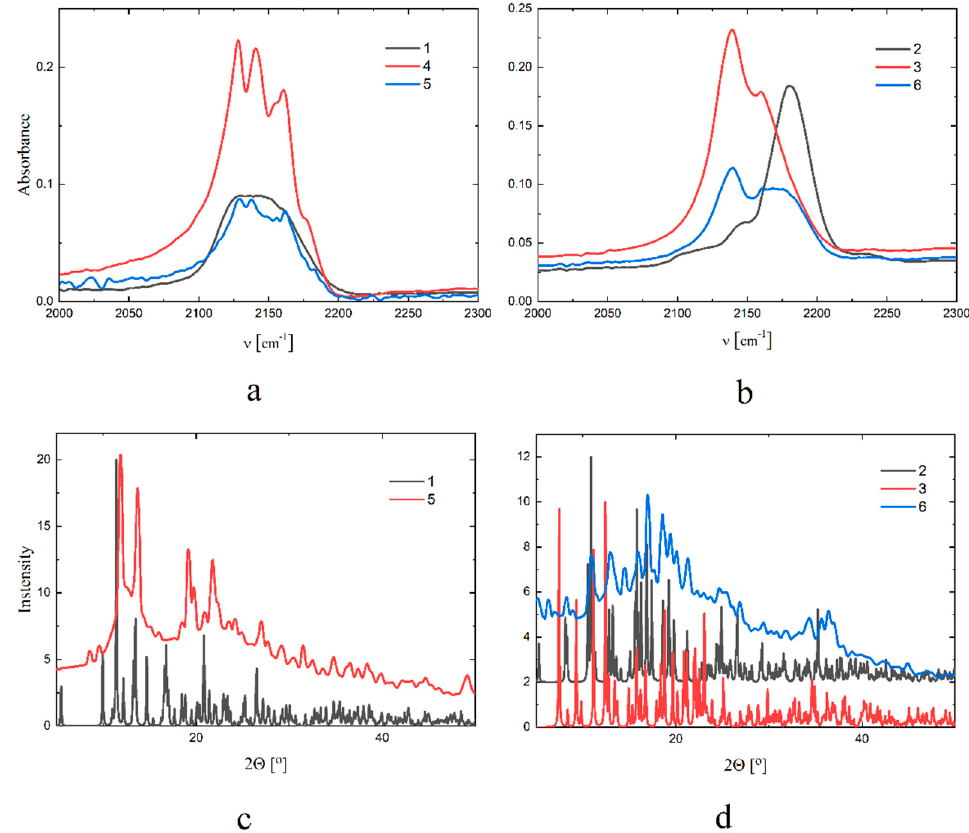
Figure 3. IR spectra of 1 , 4 and 5 ( a ) and 2 , 3 and 6 ( b ) in the ν CN range. The comparison of the powder diffractograms of 1 and 5 ( c ) and 2 , 3 and 6 ( d ). The powder diffractograms of 1 – 3 were simulated from cif files for monocrystals.